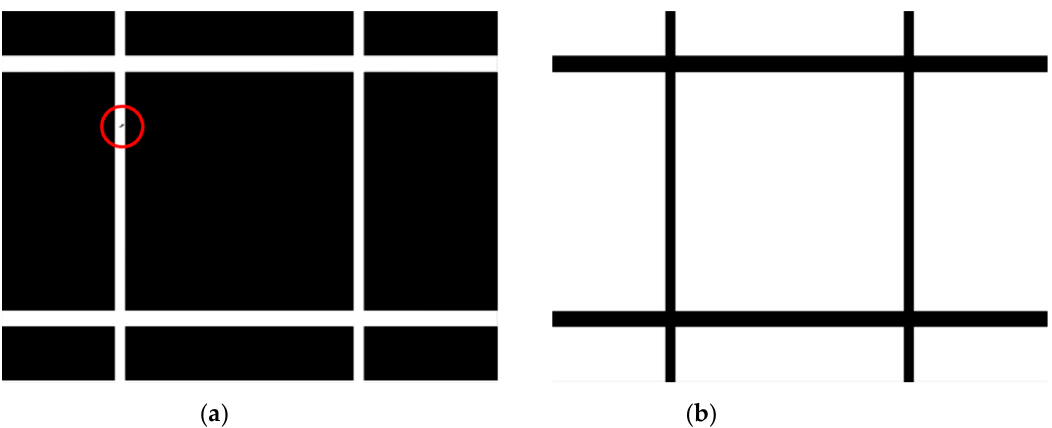
Figure 16. ( a ) Segmented interval image; ( b ) Mask for the blocks.